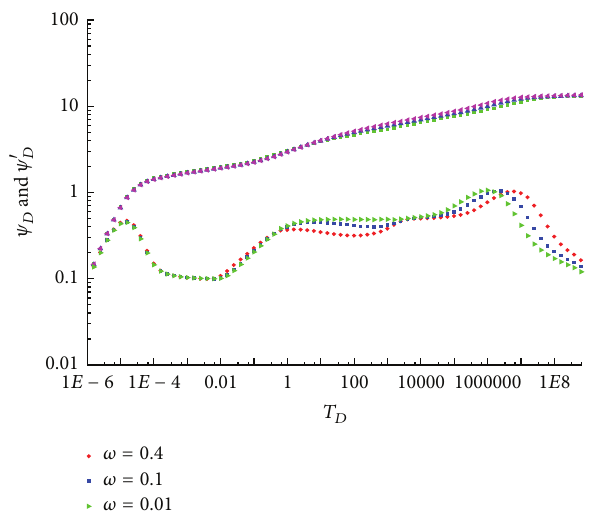
Figure 9: Influence of 𝜔 on the bottom-hole pressure with mixed boundary ( 𝜆 = 300 , 𝛽 = 50 , 𝐿 𝐷 = 2.5 , 𝑍 𝑤𝑑 = 0.5 , 𝐶 𝑑 = 0.0001 , = 50 ). 𝑠 = 1 , and 𝑟 𝑒𝐷